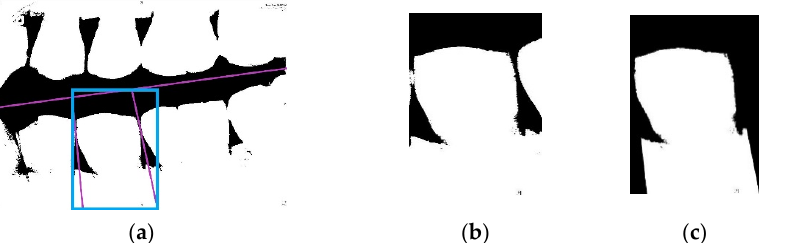
Figure 5. ( a ) A sample image misjudged by the CNN model with the three purple lines identified as the separating lines and the blue box as the area of the segmented tooth image after slicing; ( b ) sample photo of a single tooth without masking; ( c ) sample photo of a single tooth after masking the image misjudged by the CNN model.